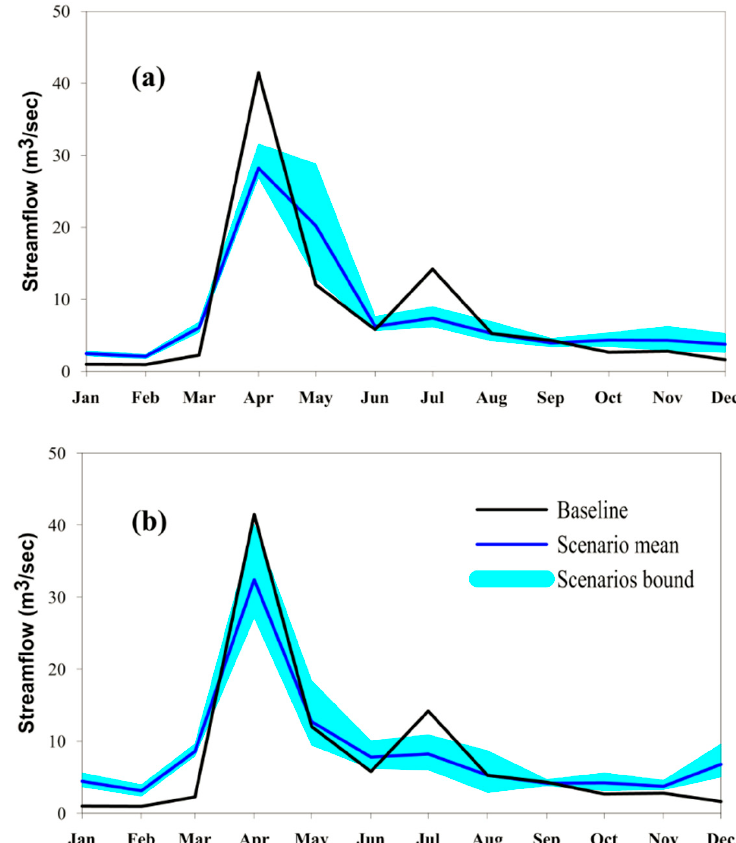
Figure 7 . Mean monthly streamflow hydrographs for the ( a ) 2030s and ( b ) 2050s under RCP 4.5 and RCP 8.5 for all climate and land use change scenarios at the catchment outlet (WSC ID: 05MD004) relative to the baseline period (1981–2010).